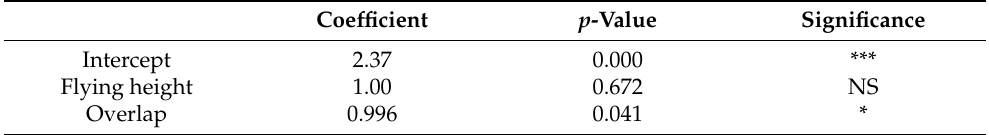
Table 7. Output of the chosen GLM model. Coefficients are on the response scale. Significance of the predictor is indicated with asterisks